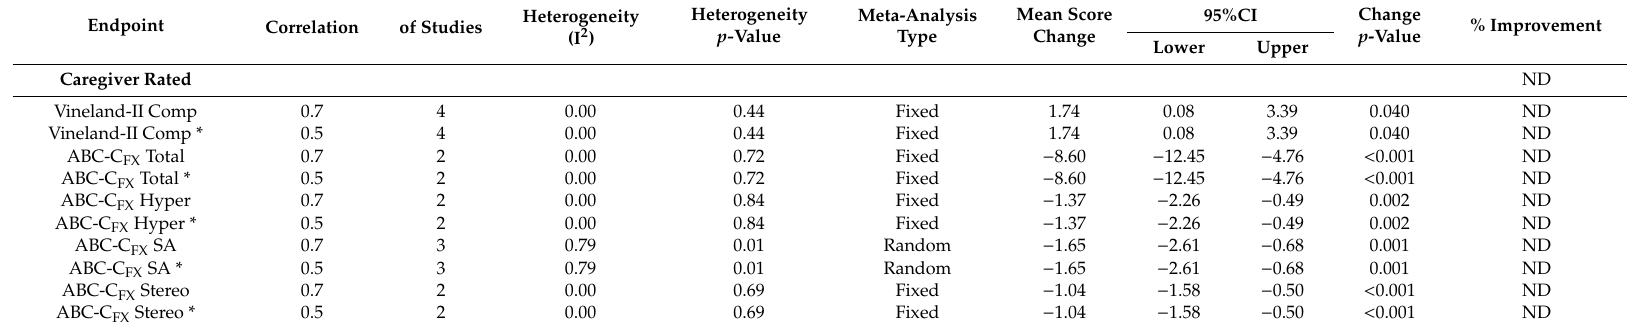
Table 5. Adolescents / adults with FXS in placebo-treated failed clinical trials: outcome measures